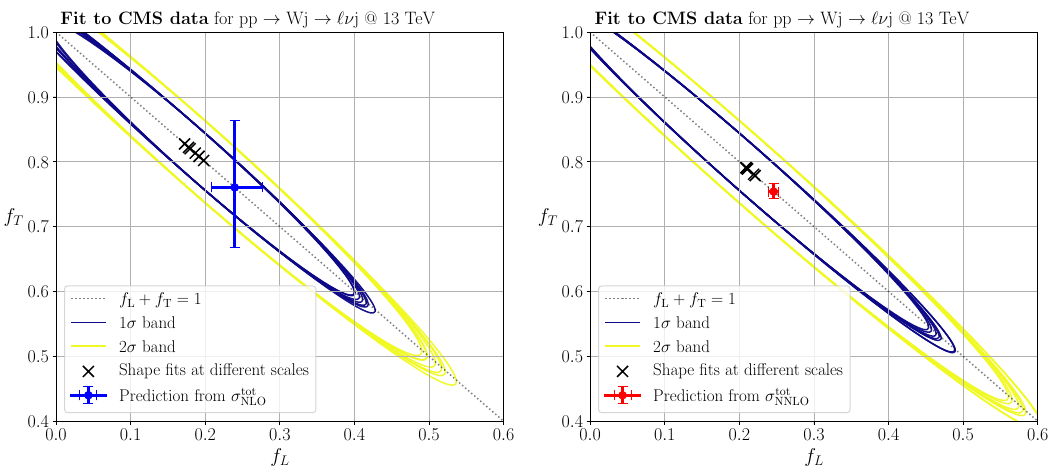
Figure 17 . Fit to the CMS data [27] of the polarisation fractions for both signatures pp → ‘ ± ( − ) ν ‘ j in the fiducial setup using the y distribution at NLO (left) and NNLO (right). Experimental j 1 systematic errors were separated from statistical errors. Statistical errors were further decreased by a factor of 3. Same plot structure as in figure 14, except for the 2 σ band which is displayed in